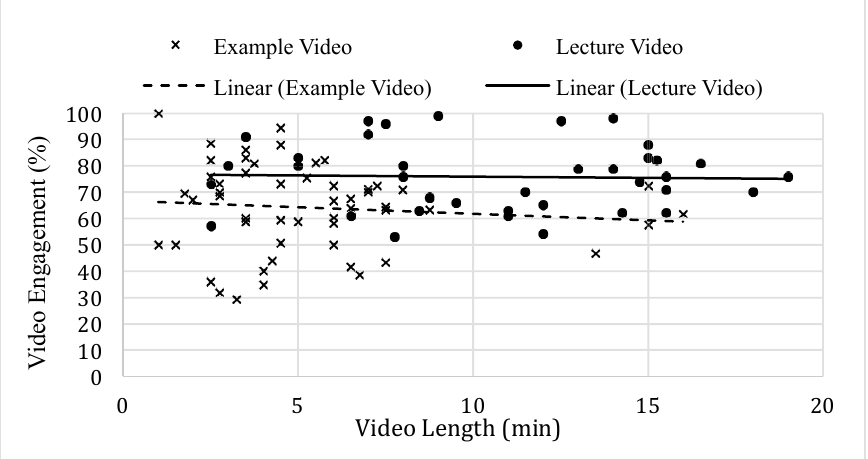
Fig. 8. Video Engagement vs. Video Length.